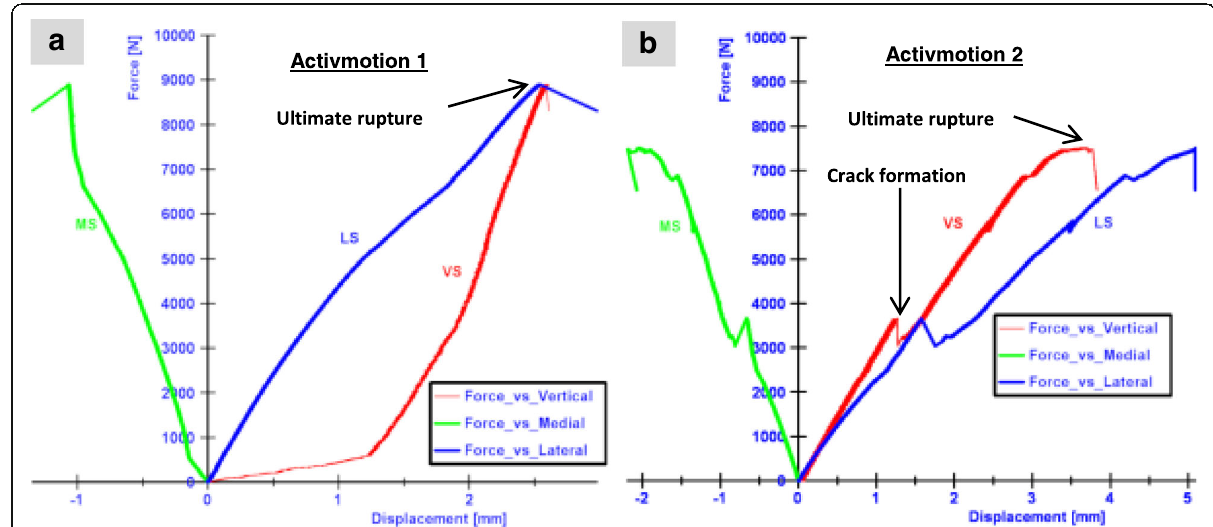
Fig. 4 Static test results: ( a ) Activmotion 1: the rupture of the lateral cortex occurred without observable cracks formation. b Activmotion 2: Cracks formations preceded the final rupture of lateral